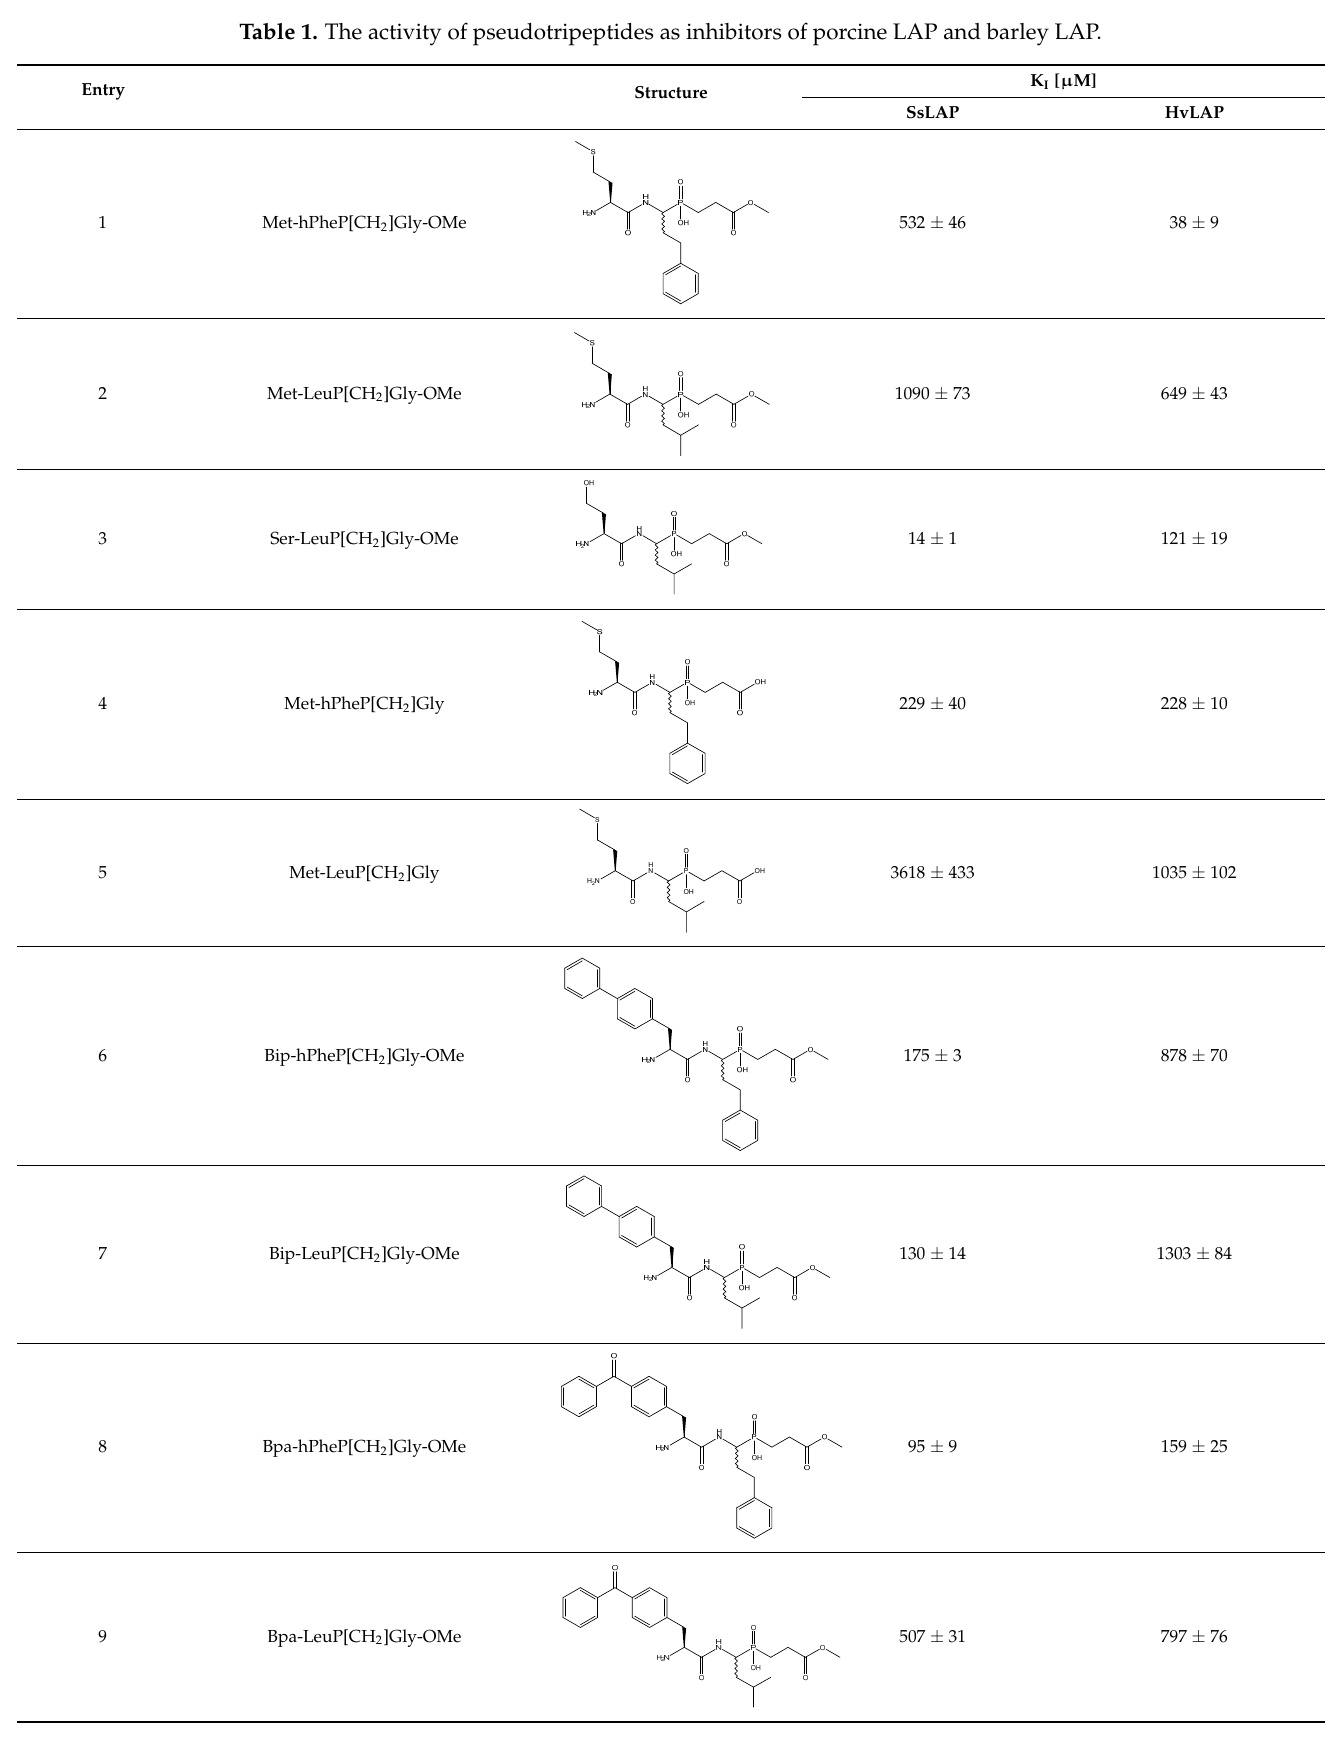
Figure 3. The designation of type inhibition and the inhibition constant K I by Dixon method for compound 3 in the presence of SsLAP.